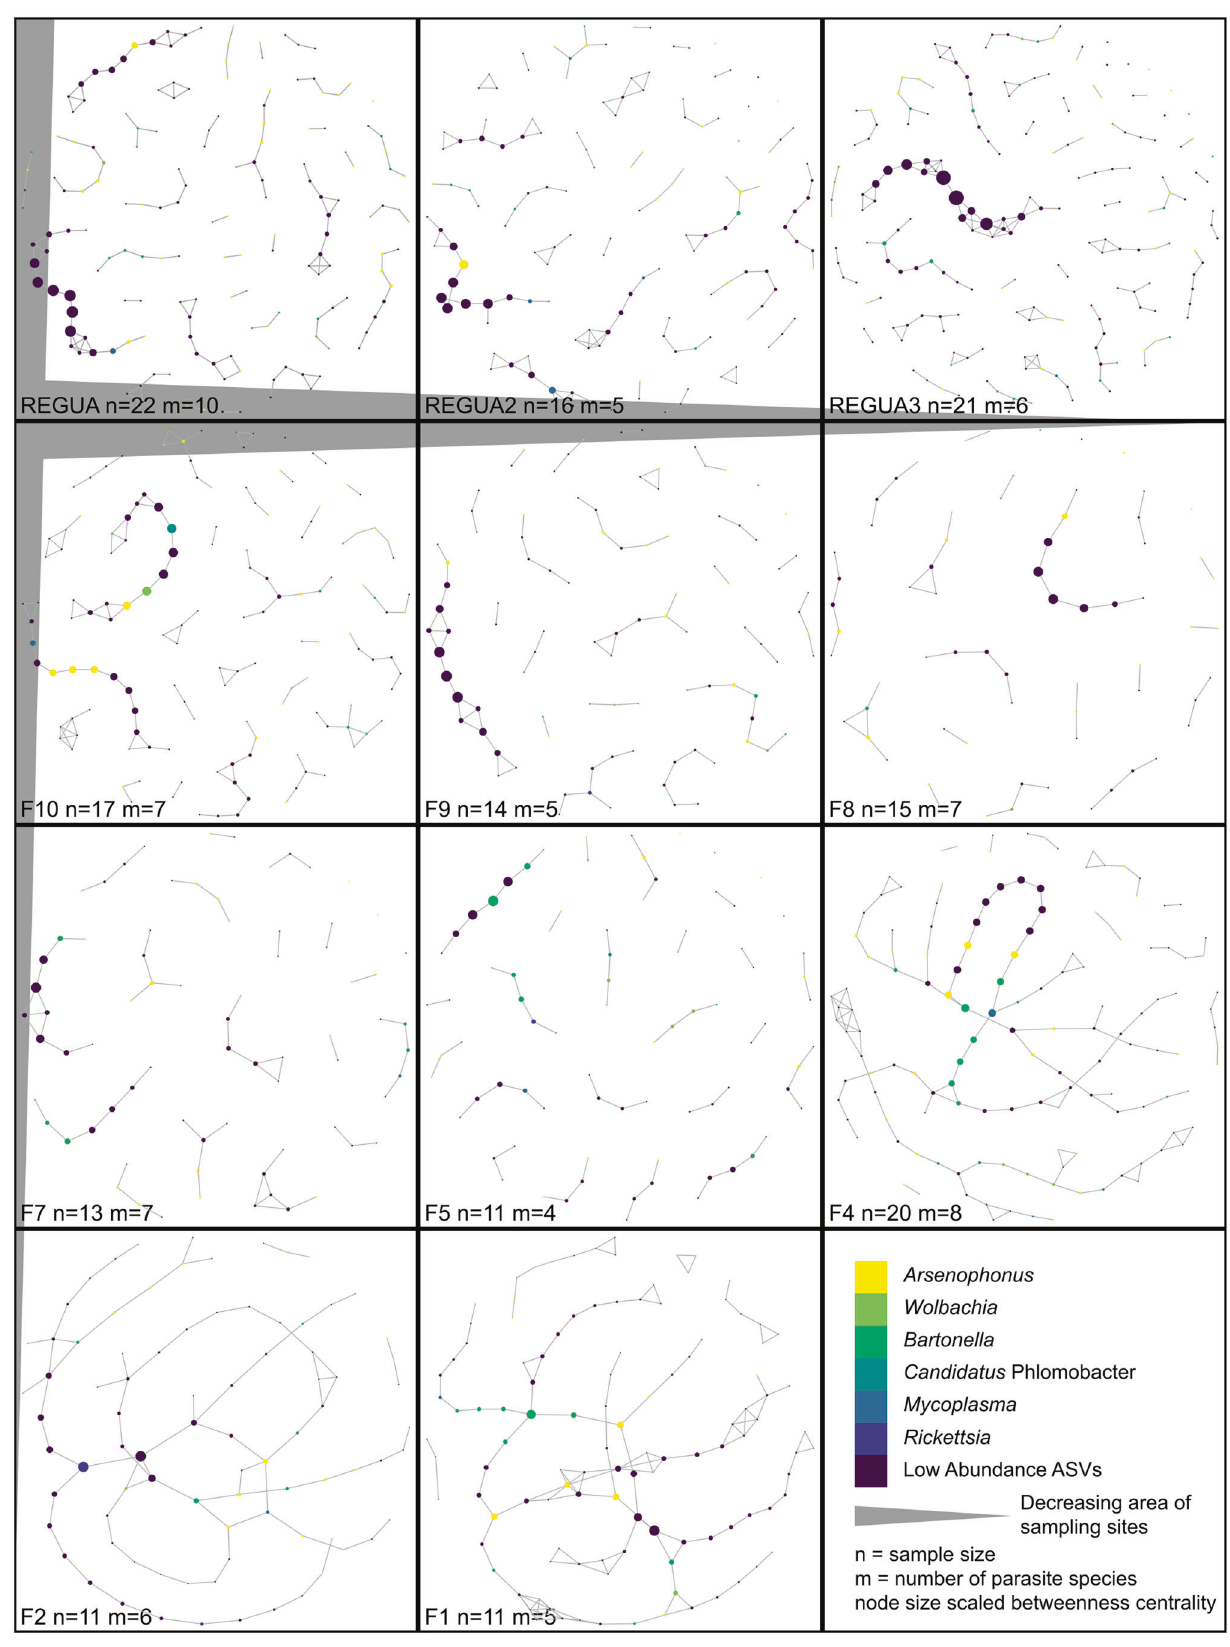
Fig. 4 Bacterial association networks. Networks for each sampling site are ordered by decreasing habitat patch area, with the largest sites in the top left and the smallest sites in the bottom right. The size of the nodes in the networks corresponds to the z-score betweenness centrality of that node scaled by the range of betweenness centralities detected within the